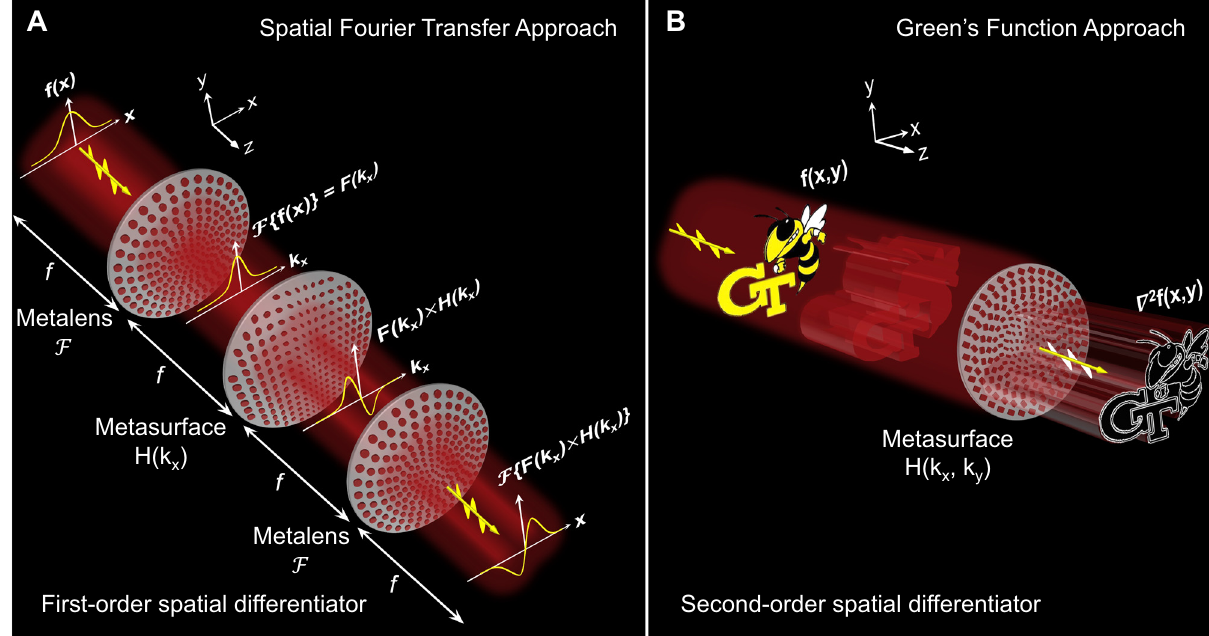
Figure1: Computationalmeta-optics.Conceptualrepresentationofspatialanalogcomputingbasedongeneralconceptsof(A)spatialFourier transfer and (B) Green ’ s function (GF) approach. The former leverages a 4 f correlator system formed by two series lenses with equal focal lengths and an intermediate complex-valued spatial fi lter located at the shared focal plane. The fi rst metalens transforms the incident light with a spatially variant pro fi le (Gaussian in this example) to the Fourier domain (i.e., k -space), while the second metalens transfers back the light processed by the intermediate metasurface to the spatial domain. The transfer function (i.e., H ( k x )) associated with the kernel of the operator of choice, one-dimensional (1D) fi rst-order differentiation in this example, is encoded into the metasurface. The latter takes advantage of the nonlocal response of an engineered single-layer optical surface or a multilayered slab that performs the desired kernel of choice. The computational system in (B) performs the second-order spatial derivation for two-dimensional (2D) edge